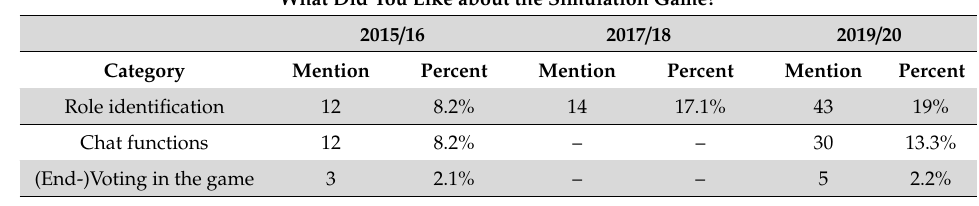
Table A1. Extract of the Results of the Qualitative Content Analysis Focusing on the Problems Discussed in the